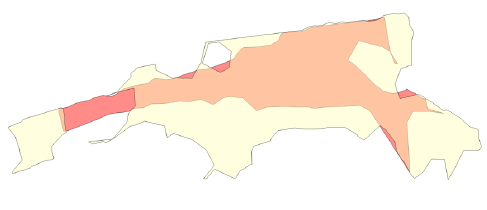
Figure 3. α -shape of the road on our Semantic3D example. In red, the horizontal extent of the road; in yellow, the extent of the non-road